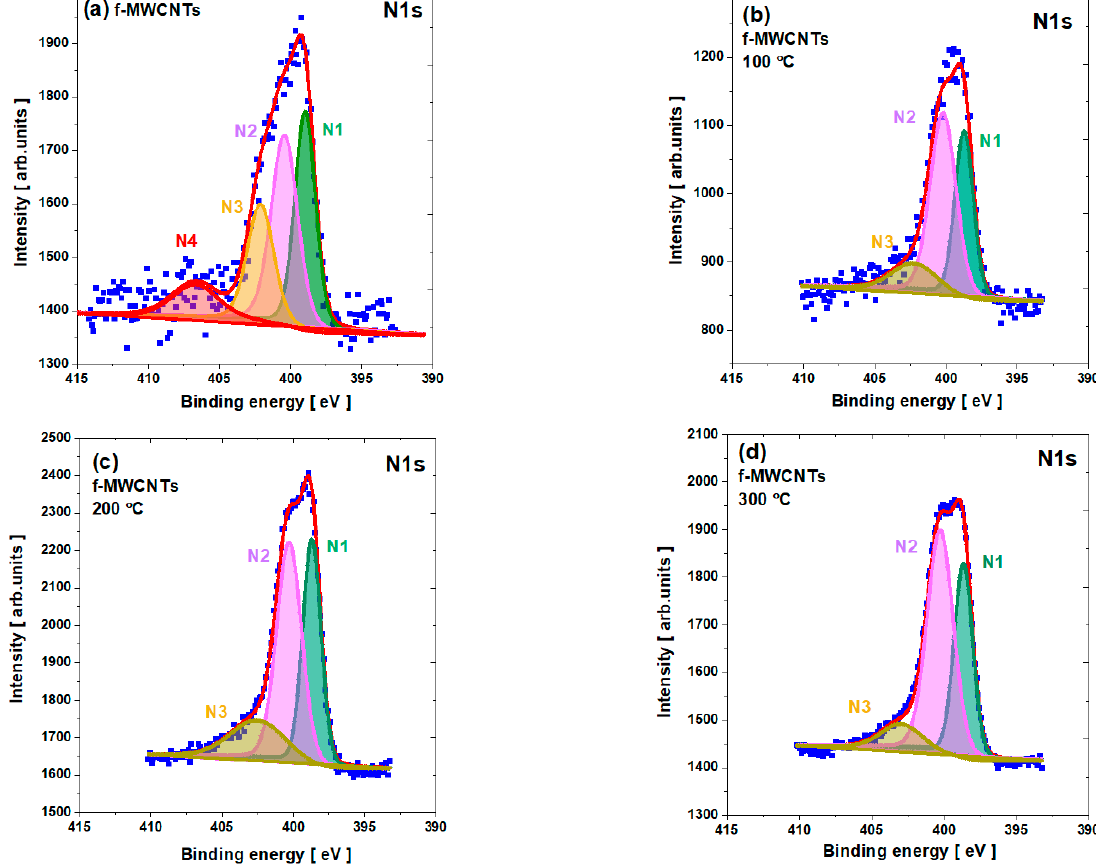
Figure 6. The N1 s core level line for f-MWCNTs: ( a ) pristine; ( b ) calcined at 100 °C; ( c ) calcined at 200 °C; and ( d ) calcined at 300 °C.